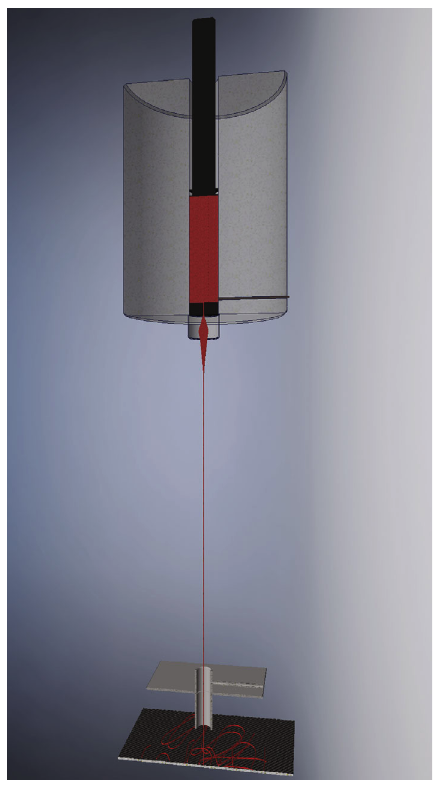
Figure 1: Schematic half-view of the capillary rheometer with piston, polymer reservoir, extrudate swell, aspirator unit, and fi bre